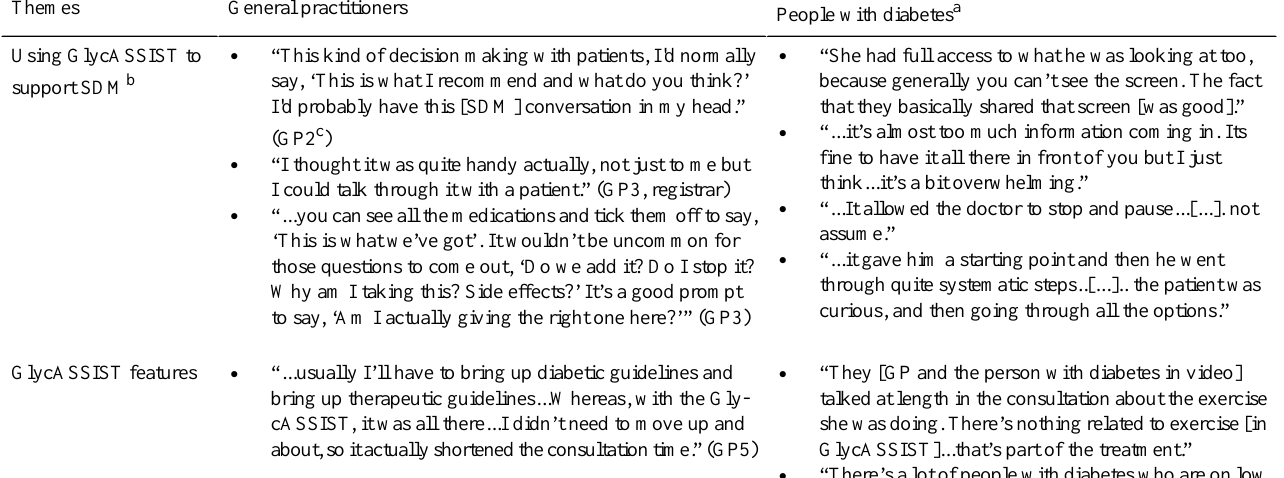
Table 2. Themes identified in stage 2 and exemplar quotes from general practitioners and people with diabetes. Using GlycASSIST